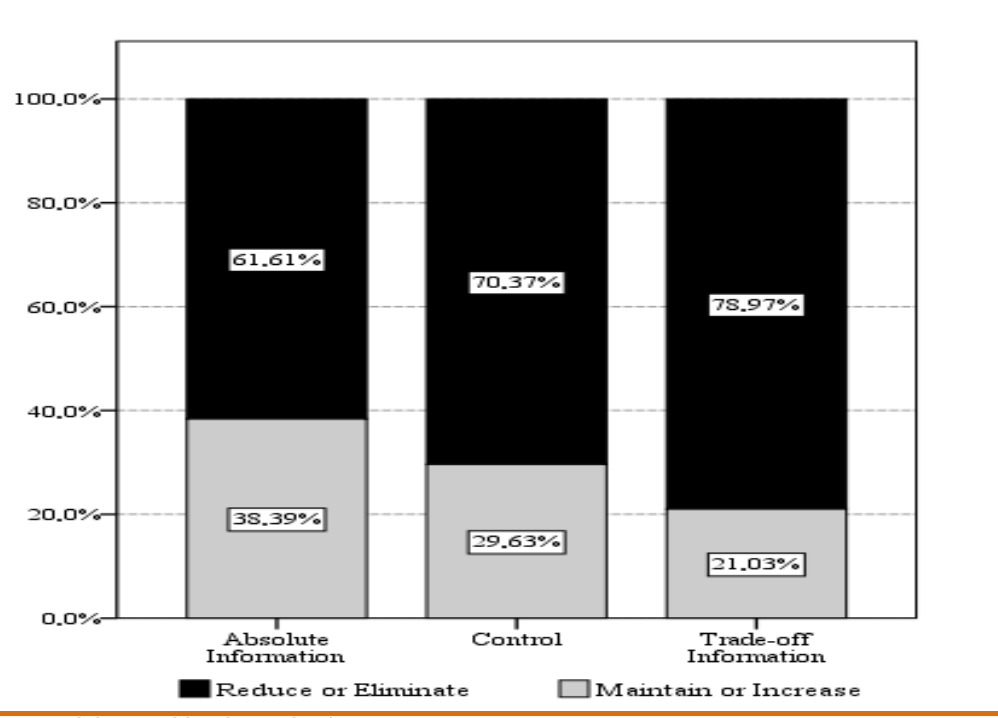
Source: Elaborated by the